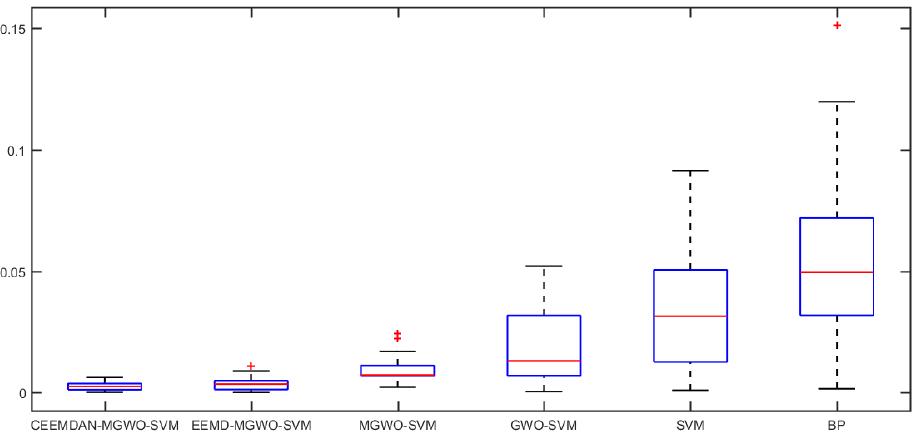
Figure 13. The boxplot of relative errors for different models.